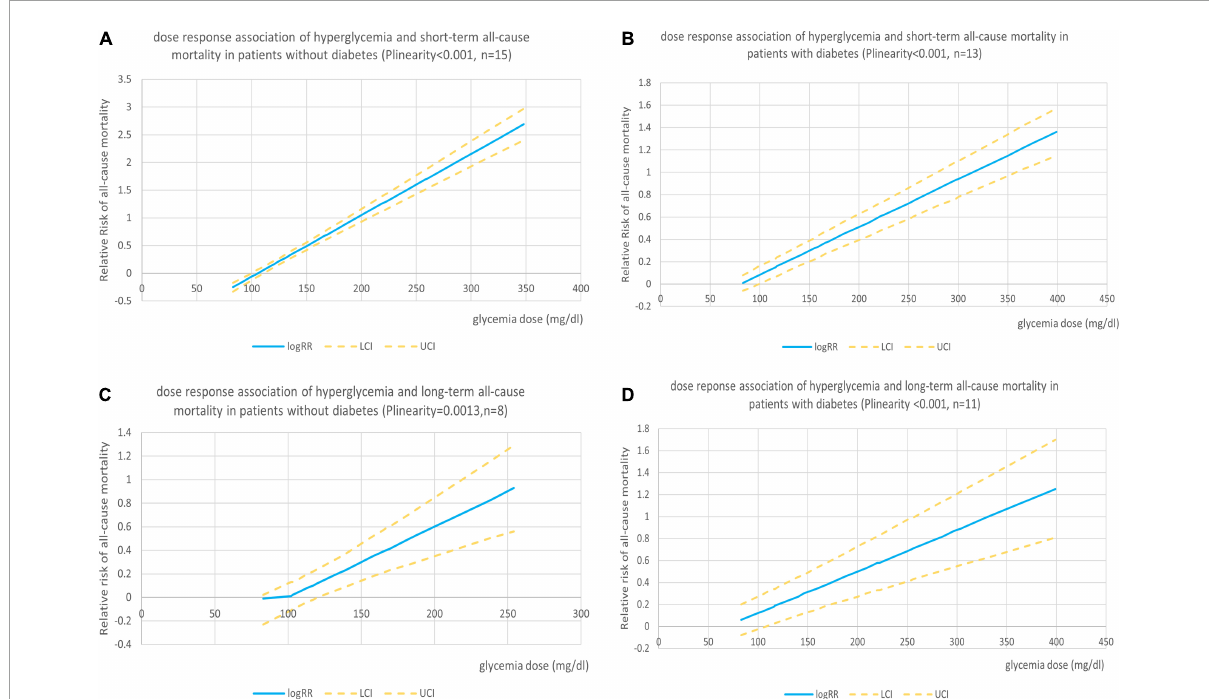
FIGURE3 (A) Dose–response association of admission hyperglycemia with short-term risk of all-cause mortality in patients with AMI without diabetes. (B) Dose–response association of admission hyperglycemia with short-term risk of all-cause mortality in patients with AMI with diabetes. (C) Dose–response association of admission hyperglycemia with long-term risk of all-cause mortality in patients with AMI without diabetes. (D) Dose–response association of admission hyperglycemia with long-term risk of all-cause mortality in patients with AMI with diabetes.